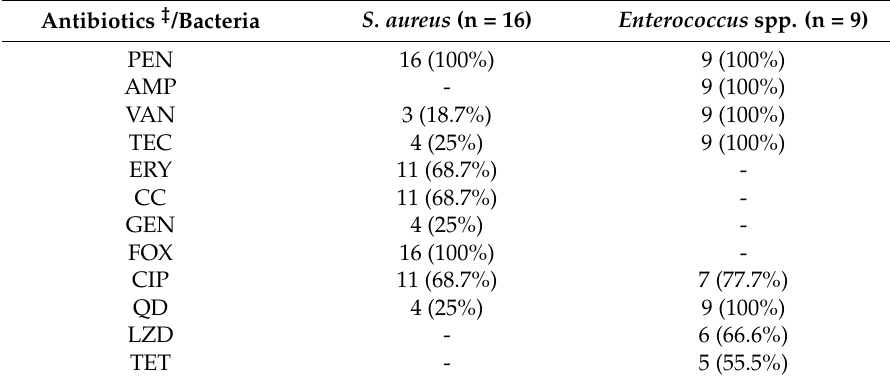
Table 2. Antimicrobial resistance (%) of the strains used in this study. Antibiotics ‡